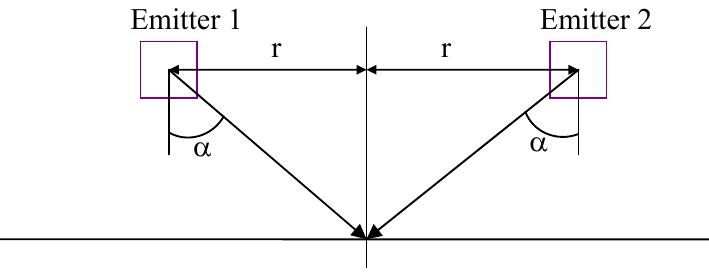
Figure 9 . Radius of reception.